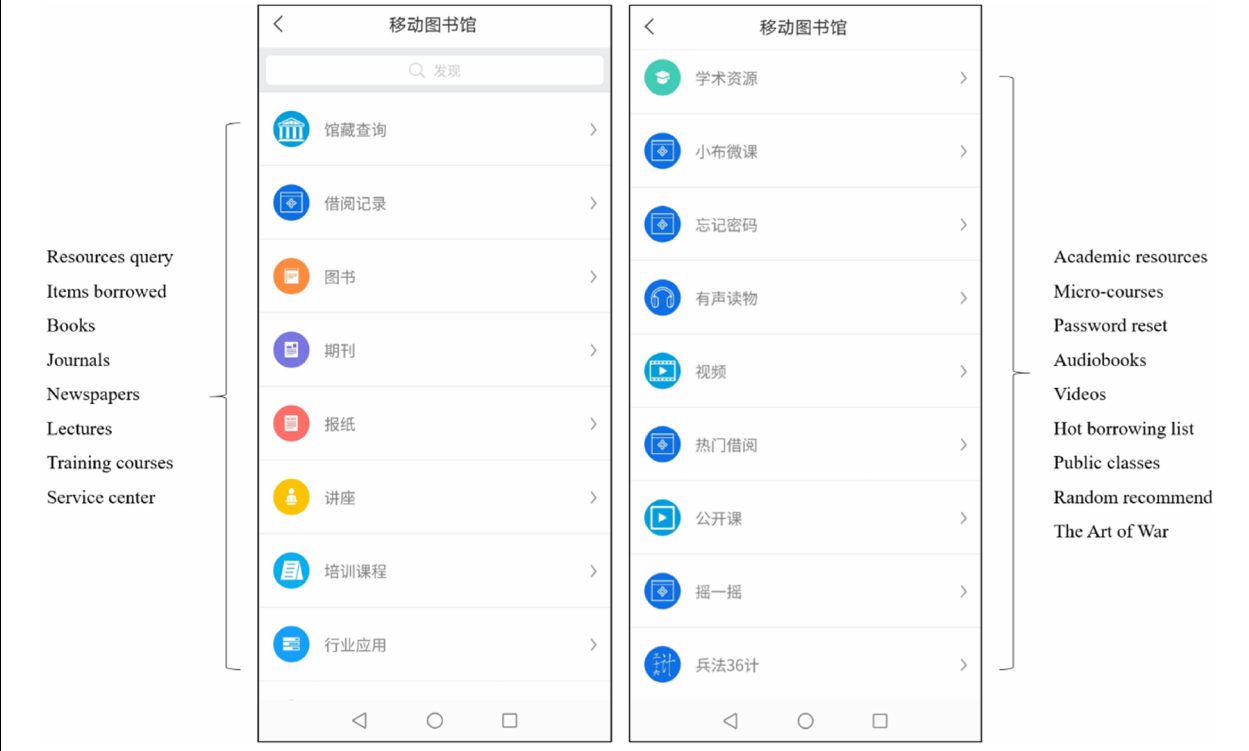
FIGURE 3 | Resource information modules of the university mobile library application.